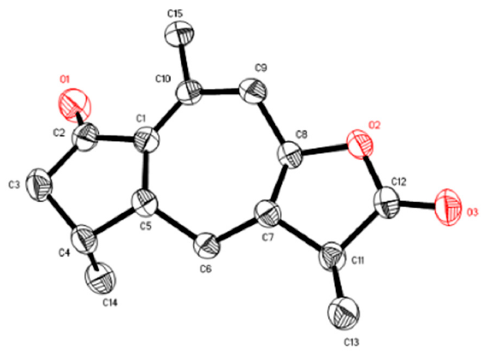
Figure 4. ORTEP diagram of compound 1 .